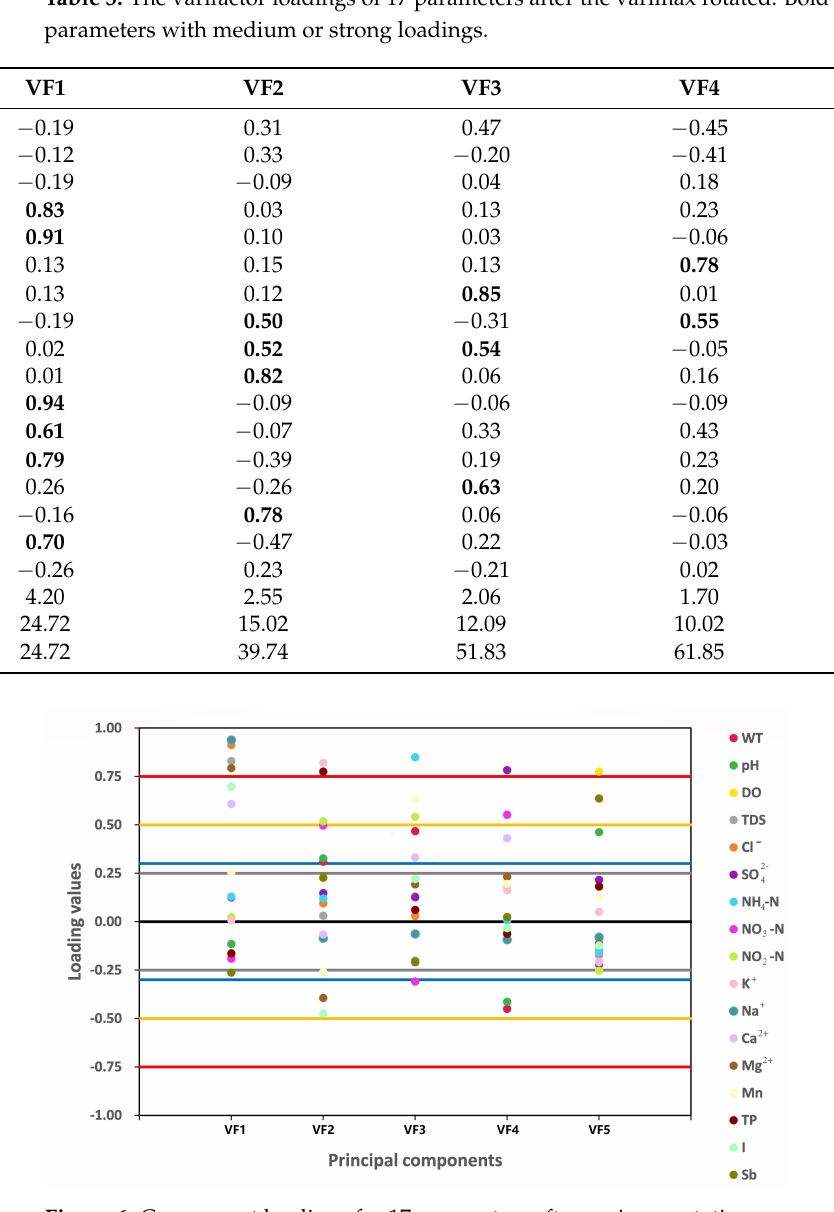
Figure 6. Component loadings for 17 parameters after varimax